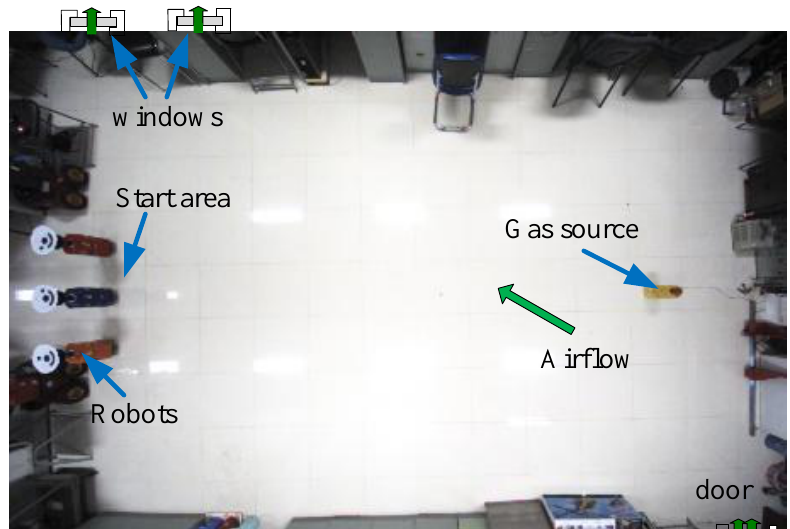
Figure 7. Arena II as seen from the overhead